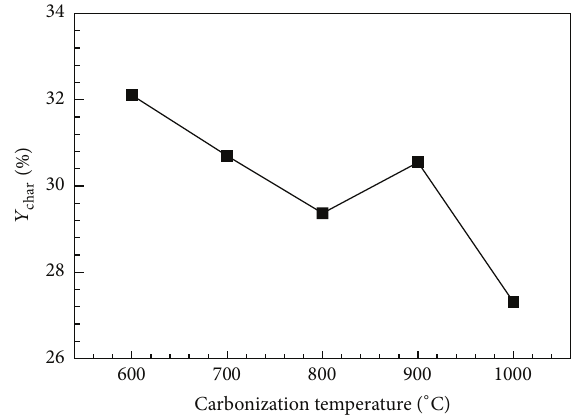
Figure 4: Charcoal yields for various carbonization temperatures.